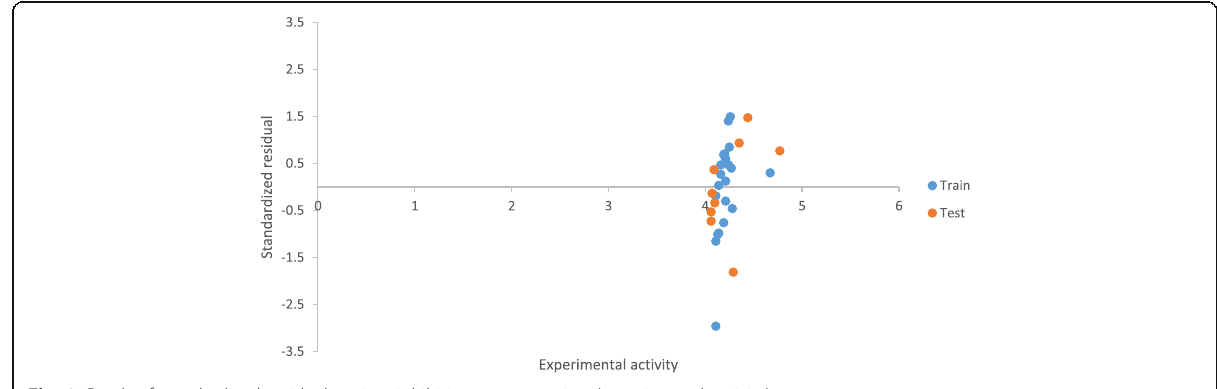
Fig. 3 Graph of standardized residual against inhibition concentration (experimental activity)